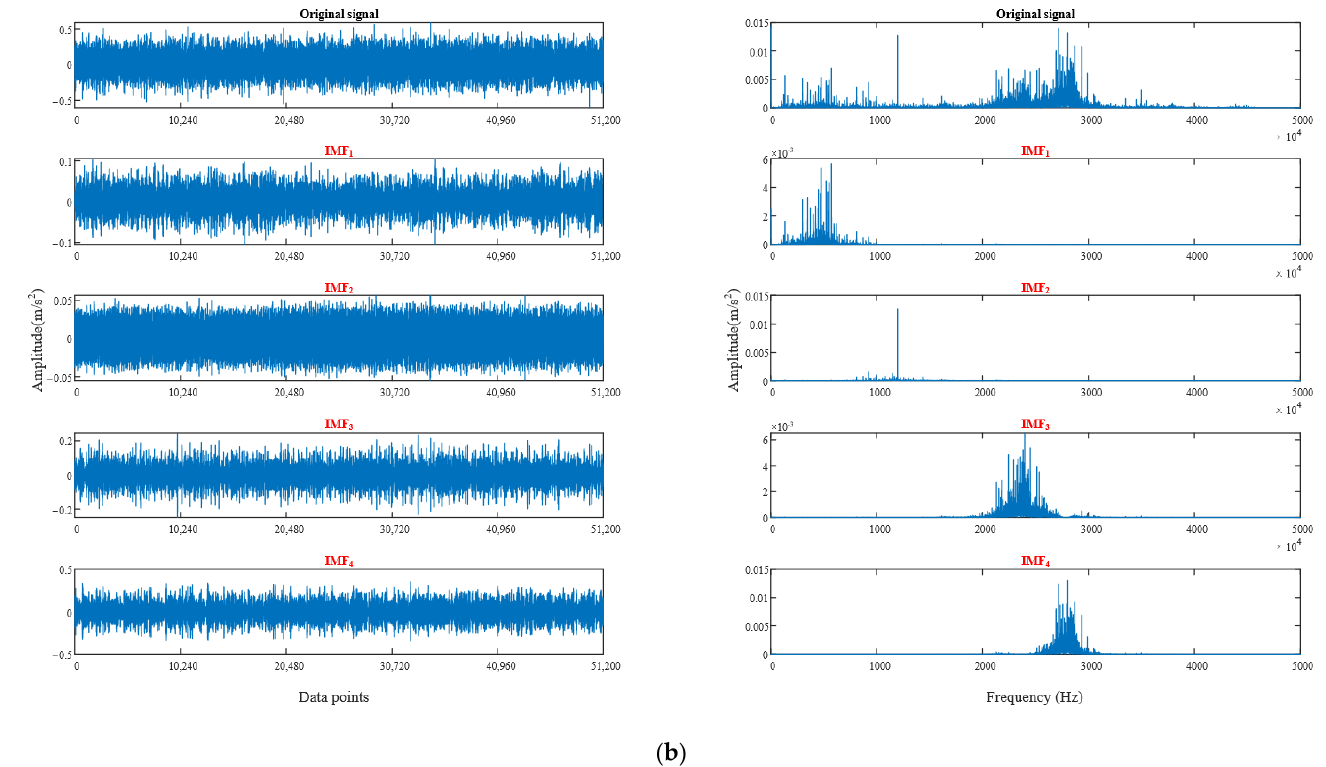
Figure 8. Time domain waveform and spectrum diagram of vibration signal decomposed by WGWOA-VMD, ( a ) inner ring fault, ( b ) rolling body fault.